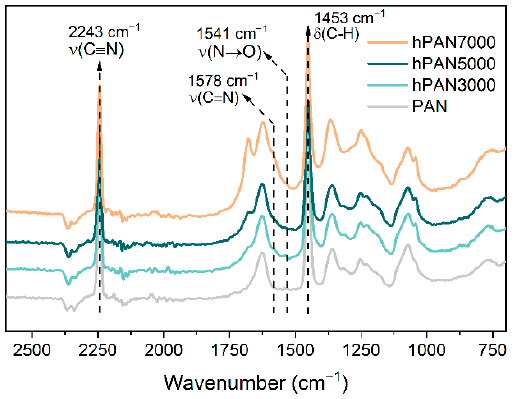
Figure 4. FTIR spectra of the unmodified PAN, hPAN3000, hPAN5000, and hPAN7000.